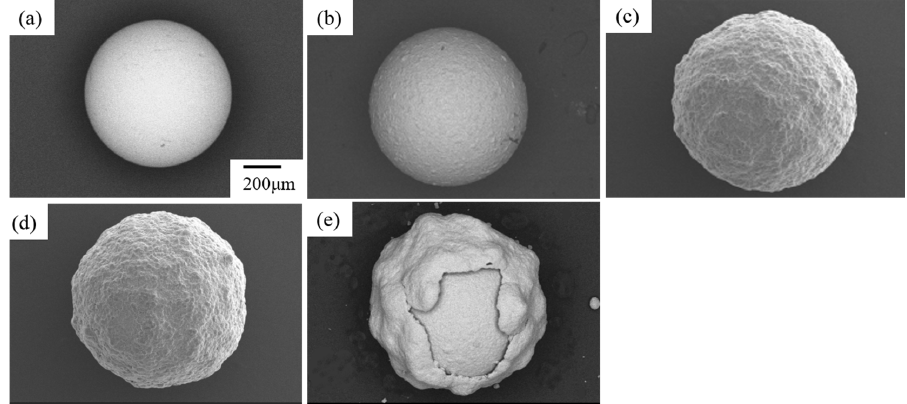
Figure 9. SEM images of surface morphologies of Ti coatings on stainless steel (SUS-304) balls prepared by mechanical coating at 300 rpm after different duration: ( a ) 0 h; ( b ) 4 h; ( c ) 10 h; ( d ) 16 h and ( e ) 60 h.